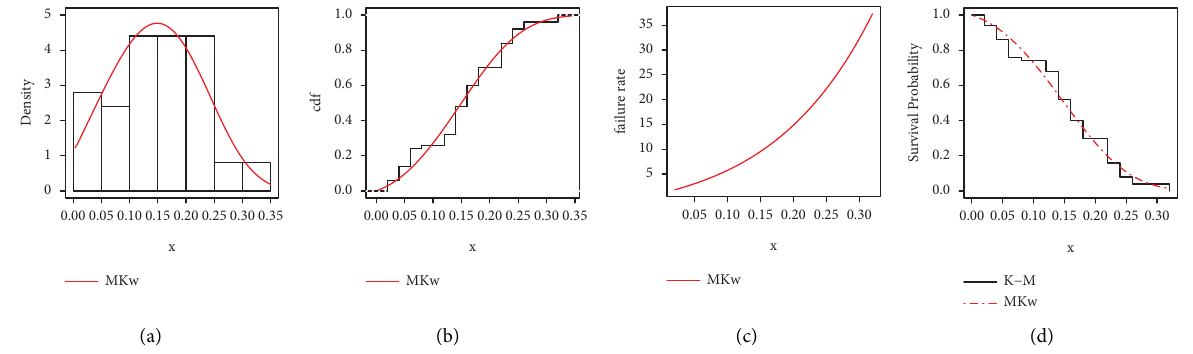
Figure 8: Plots of estimated pdf, estimated cdf, estimated hrf, and failure rate for data set